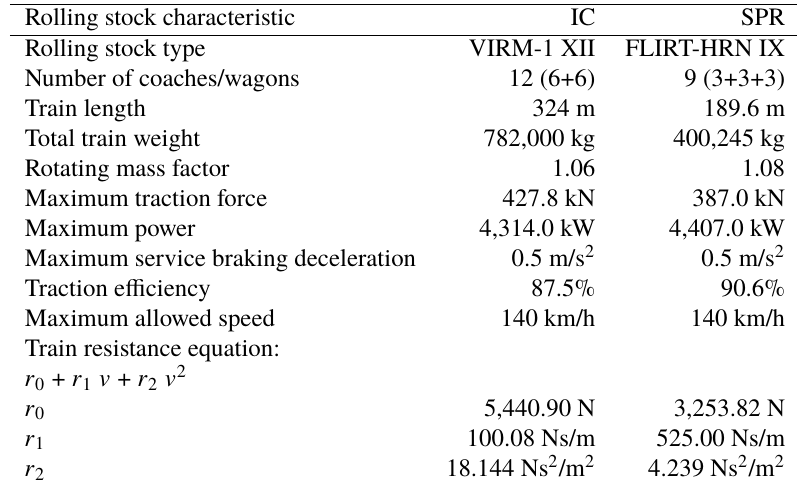
Table 7: Standard rolling stock characteristics (NS, 2020).